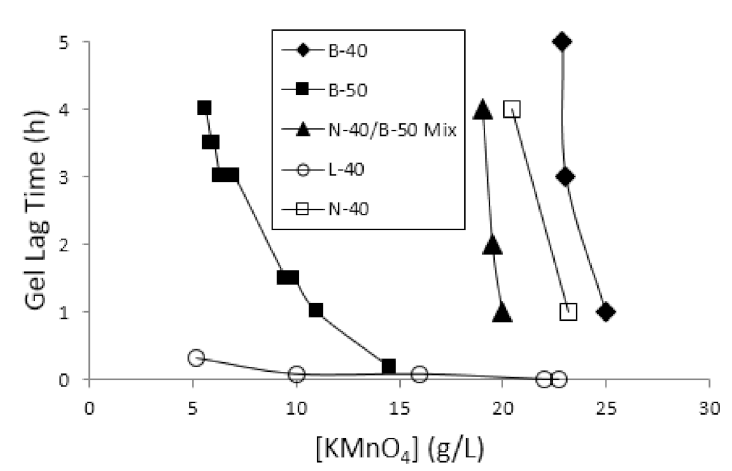
Figure 3. Gelation lag time results from column flow-through tests for Bindzil 1440, Bindzil 9950, Nalco 1142/Bindzil 9950 mix, Nalco 1142, and Ludox TM-40